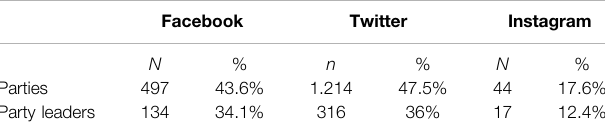
TABLE 2 | Traditional media shares on Facebook, Twitter, and